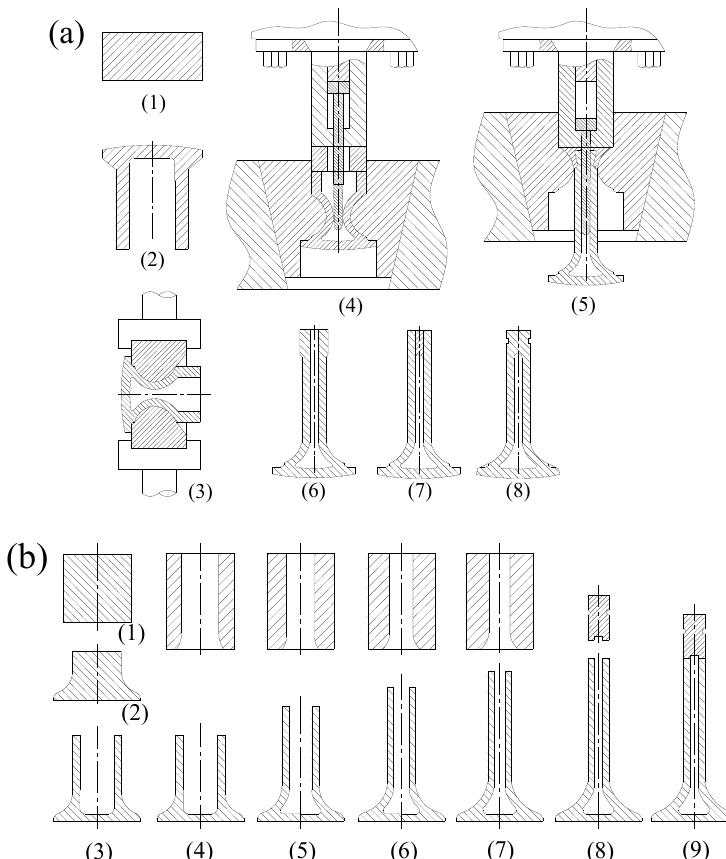
Figure 1. Two methods of hollow head and sodium filled engine valves (HHSV): ( a ) Necking and extruding method proposed by Norton [8]; ( b ) Cold forming necking method proposed by Yoshimura [9].